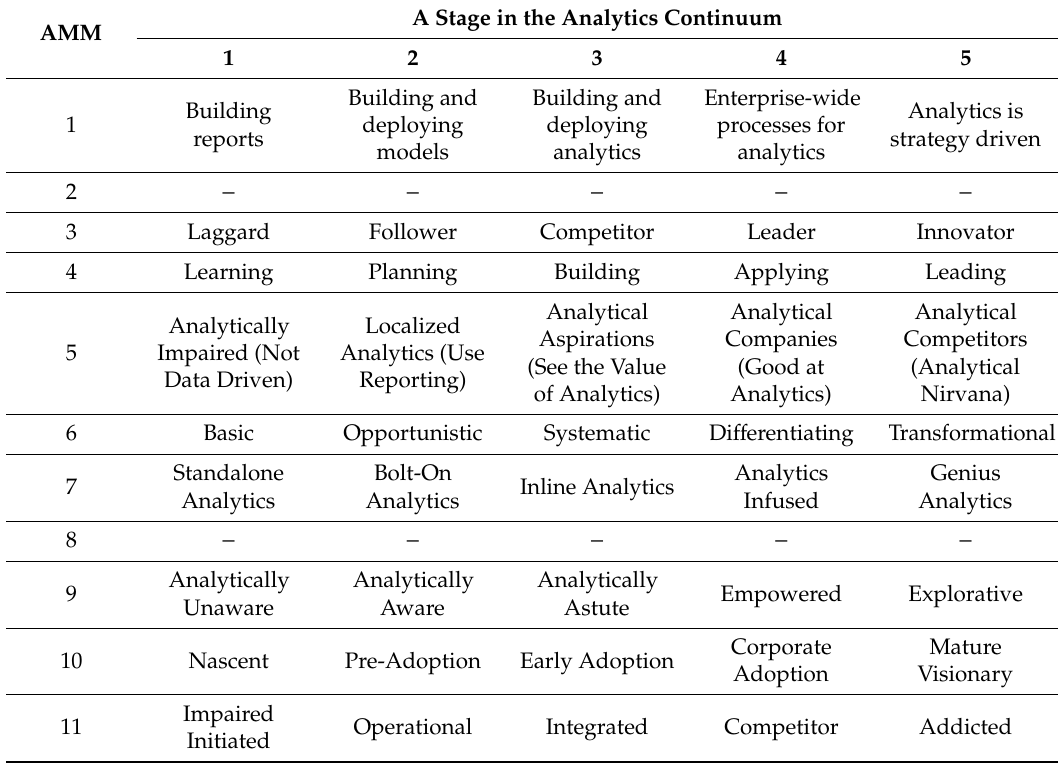
Table 3. Comparison of the nomenclature of stages in the analytics continuum.